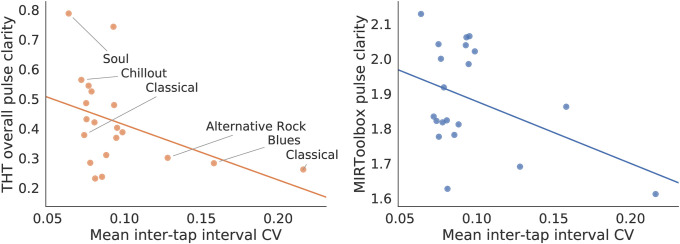
Pulse clarity score compared against tapping variability.Left: THT clarity score is calculated as the mean congruency score of the top hypotheses. Tapping precision is calculated as the mean coefficient of variability of the inter-tap interval distribution. Each point represents one track in the MIREX Beat Tracking training dataset. Spearman correlation has r = −0.534 (p = 0.015). Genres of least and most variable tapping scenarios (on average) are annotated in the plot. Right: Pulse clarity score from MIRToolbox [5] compared against tapping variability (Spearman r = −0.149, p = 0.531).